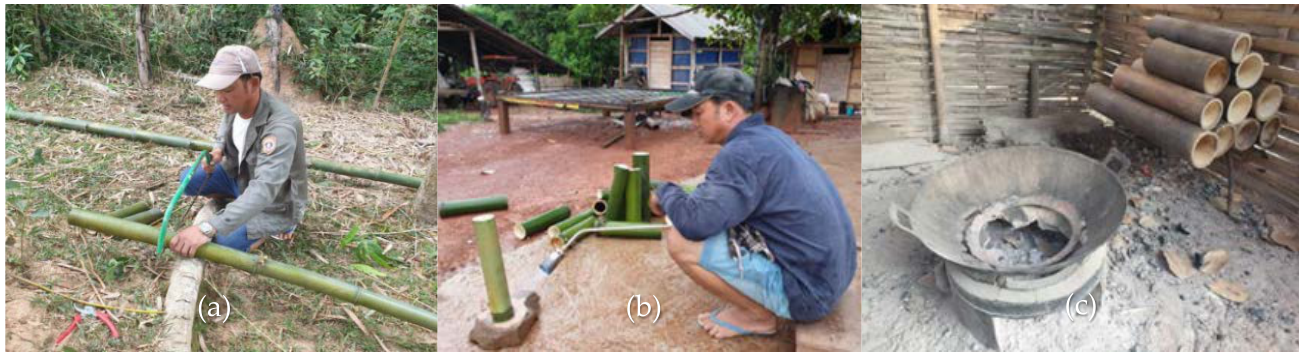
Figure 6. Bamboo harvesting, collection, and management steps: ( a ) cutting bamboo culm by node, ( b ) treating bamboo outer skin with gas torch, and ( c ) drying the treated bamboo material using a kitchen stove.